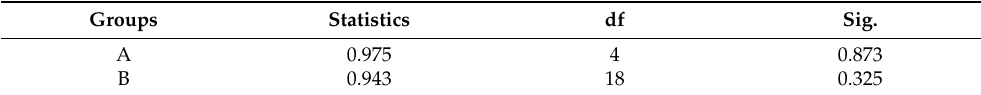
Table 3. Normality test results of the two data segments by the SW